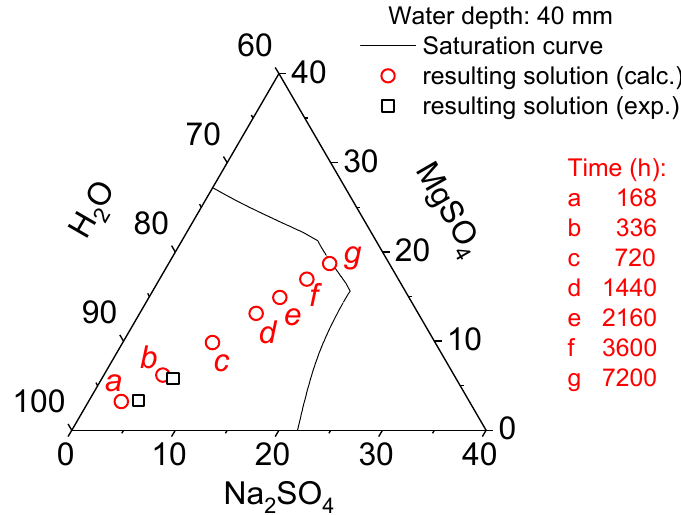
Figure 10. The composition of the resulting solution in the phase diagram in the dissolution and diffusion processes of bloedite.